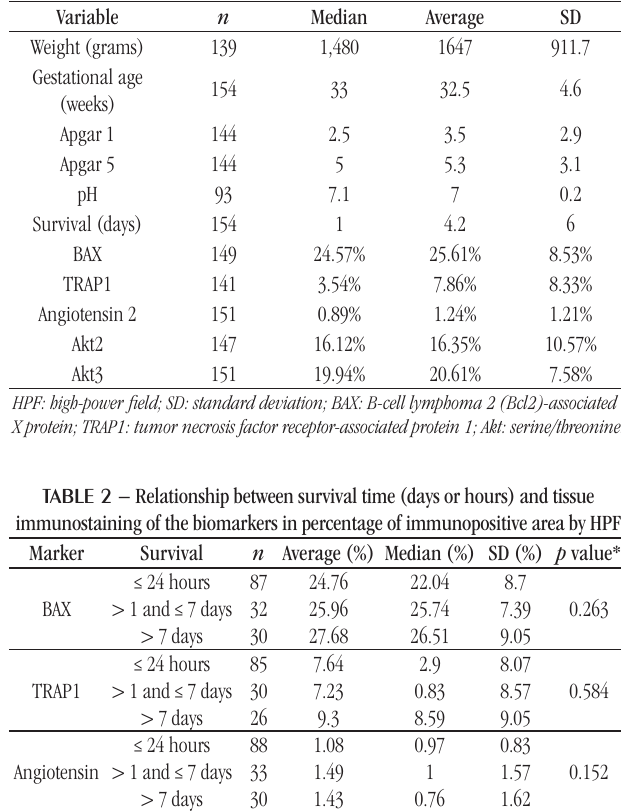
taBLE 1 − Pathological and clinical parameters of the sample and tissue immunostaining of the biomarkers in percentage of immunopositive area by HPF